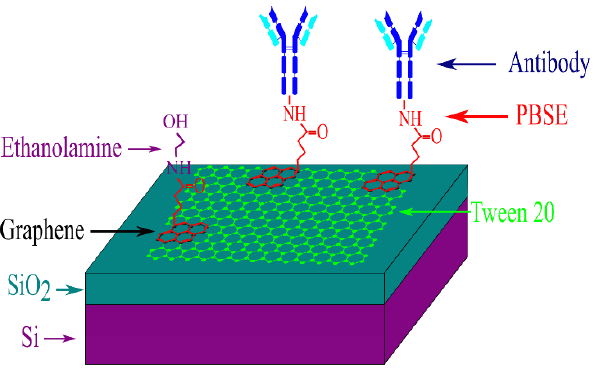
Figure 2. Schematic representation of the device after the functionalization steps described in the text.